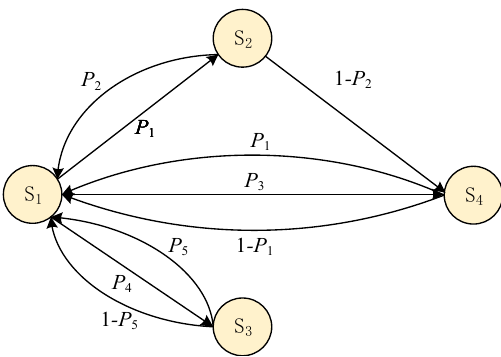
Figure 3. Markov chain